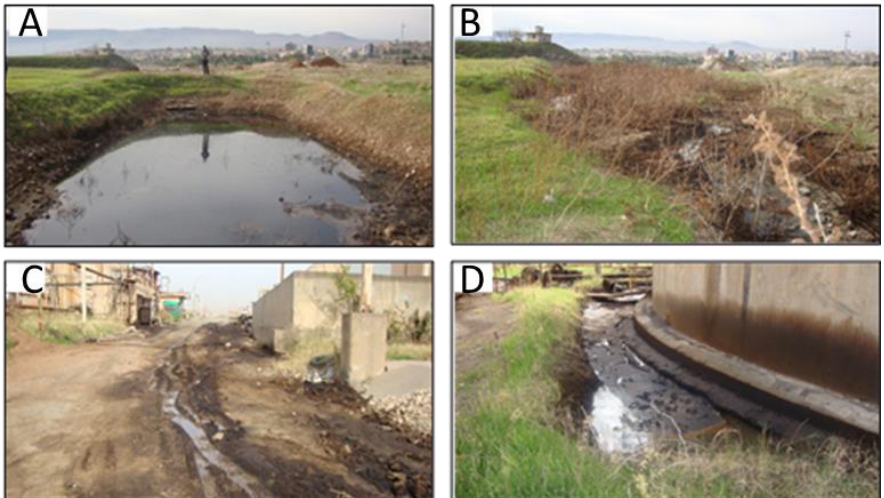
Figure 1. Improper management of oil products, ( A ) Pool of oil in O.R, ( B ) Soil polluted by oil product, ( C ) area around O.R polluted by oil products, ( D ) Oil leakage from old tanks.